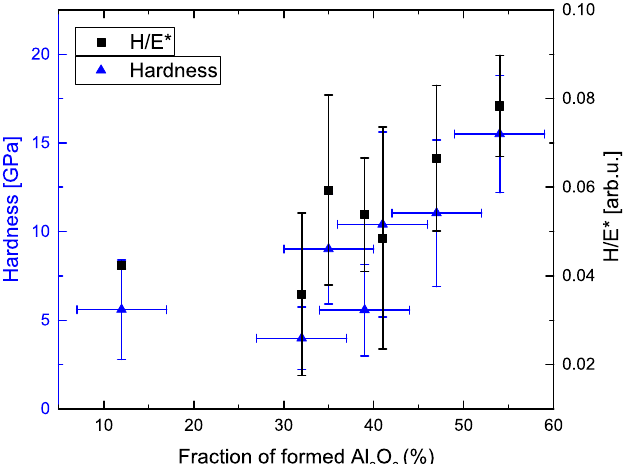
Figure 8. Hardness H and ratio H/E* depending on the amount of total formed alumina ( α + γ phase).